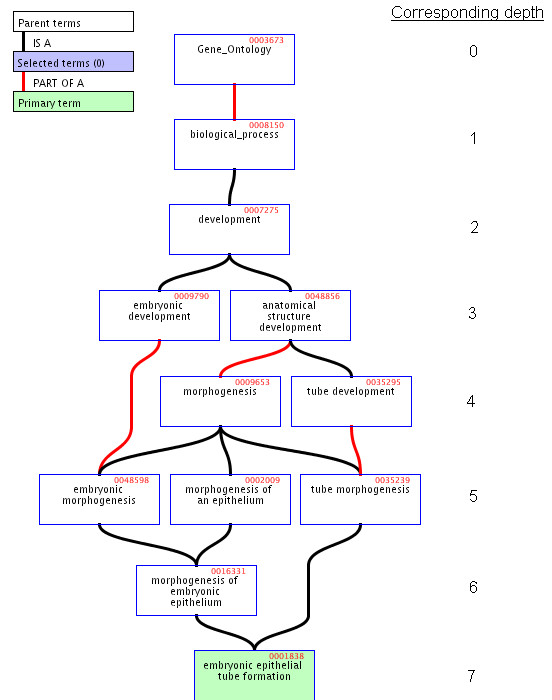
Depth of GO terms.